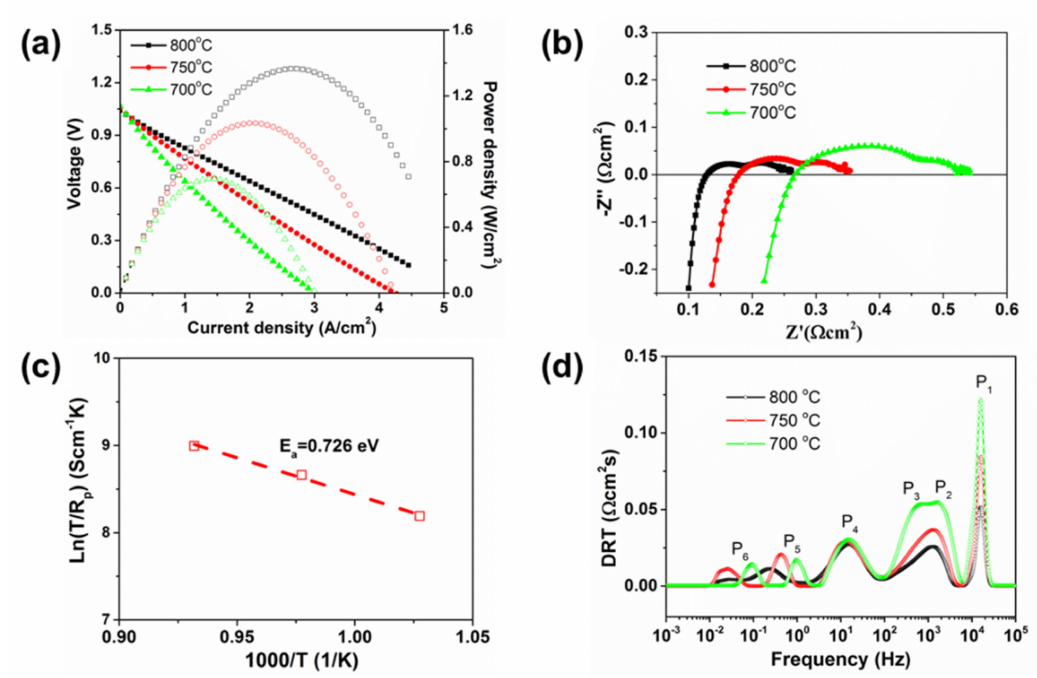
Figure 3. ( a ) I–V discharge curves, ( b ) the impedance spectra, ( c ) the activation energy for the polarization process and ( d ) the distribution of relaxation times (DRT) analysis of the impedance spectra of the directly assembled LSF cell in solid oxide fuel cell (SOFC) mode at 700–800 ◦